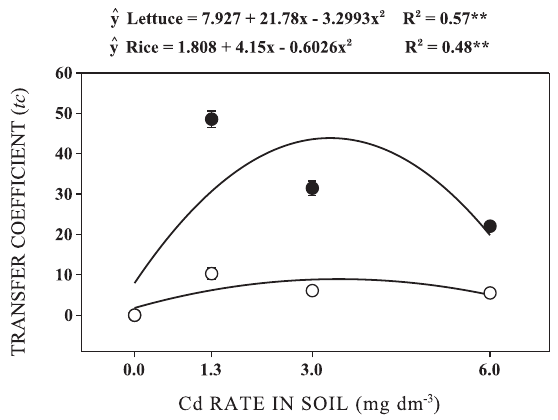
Figure 3. Effect of Cd rates applied to the soil on the Cd transfer coefficients (ratio between plant shoot Cd mg kg -1 / soil total Cd mg kg -1 ) to plants of rice ( ) and lettuce (